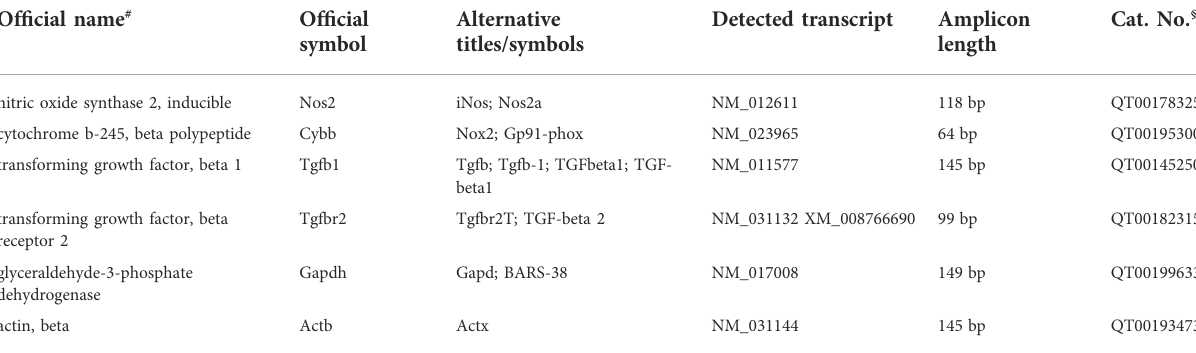
TABLE 1 The list of primers used for quantitative real-time PCR